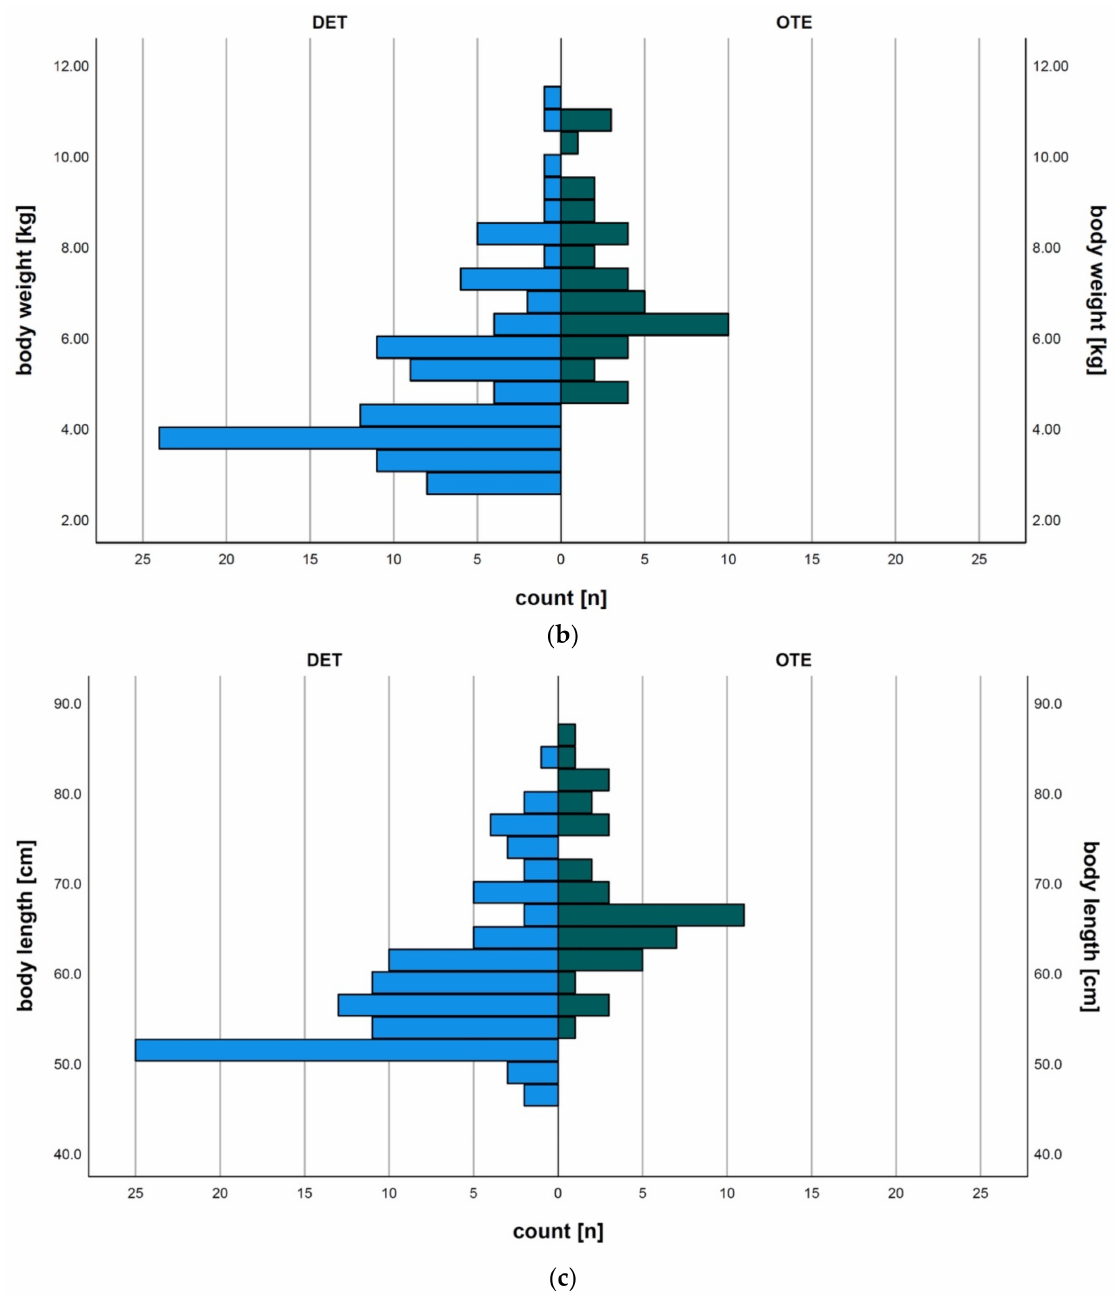
Figure 1. Population pyramid illustrates the distribution of patients in relation to ( a ) age (days of life); ( b ) body weight (kg); ( c ) height (cm). Blue bars represent delayed extubation group (DET) versus on-table extubation (OTE) green